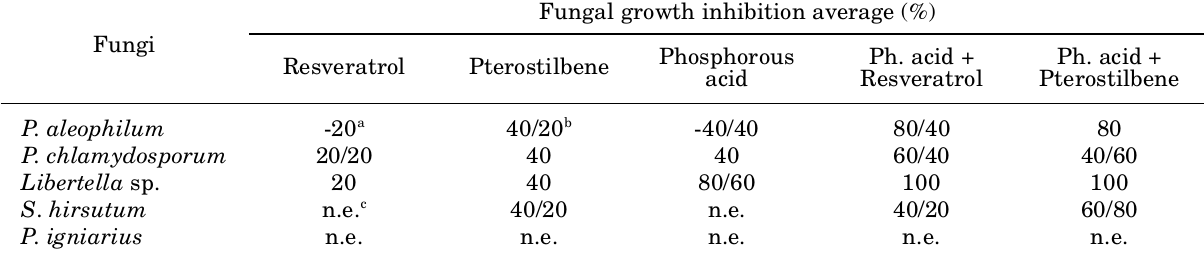
Table 1. In vitro average percentage of mycelial growth inhibition on esca fungi by phosphorous acid and stilbenes (from Di Marco et al. ,